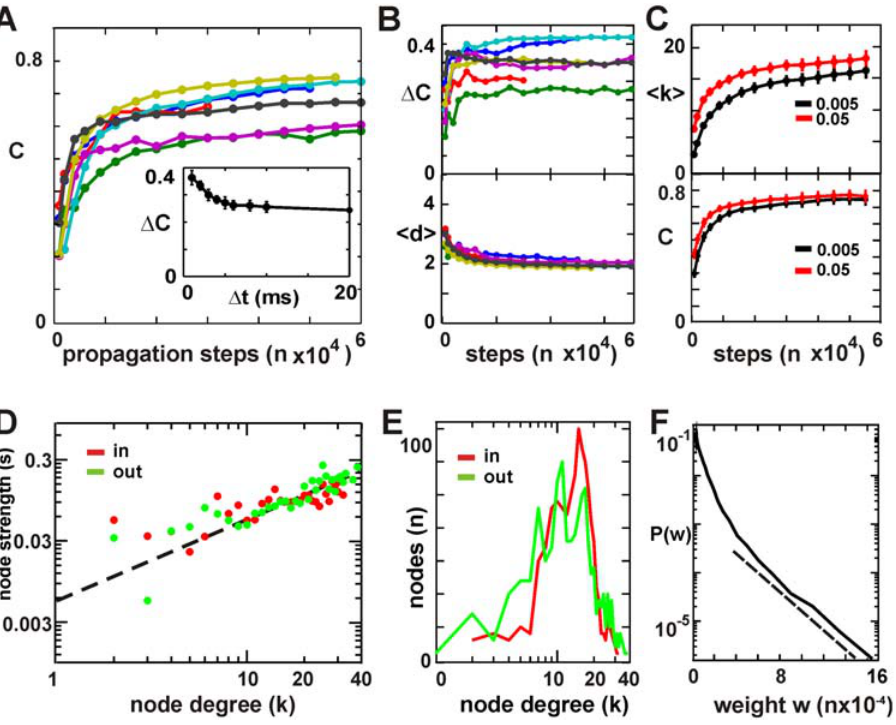
Figure 8. Neuronal avalanches reveal a functional small-world topology. (A) The clustering coefficient C converges to a high and constant value with increasing number of propagation steps for all 7 networks studied. Inset: Average excess clustering coefficient D C for all networks and different D t . Note that D C does not represent an error of reconstruction, but an important network property that measures specificity in network clustering. The quality of reconstruction should be judged by whether or how fast it approaches the correct steady value (B) Corresponding change in D C (top) and mean path length S d T (bottom)) for the networks reconstructed in A. Small-world topology is defined by a high excess clustering D C and low S d T . (C) Average change in mean node degree S k d T and C for two significance values in link reconstruction. Note robustness of C to an increase in significance whether link exists. (D) The node degree is linearly related to the node weight for both in and out degrees. Broken line: slope=1. Each network reconstructed at 30,000 steps with links smaller than 20% of the maximal traffic pruned. (E) Node degree distributions for in and out degrees reveal a predominance of nodes with 10–20 links. (F) Semi-logarithmic plot of link weight probability demonstrates the presence of an exponential decay (broken line) for links with high traffic. (D–F) All networks from (A)